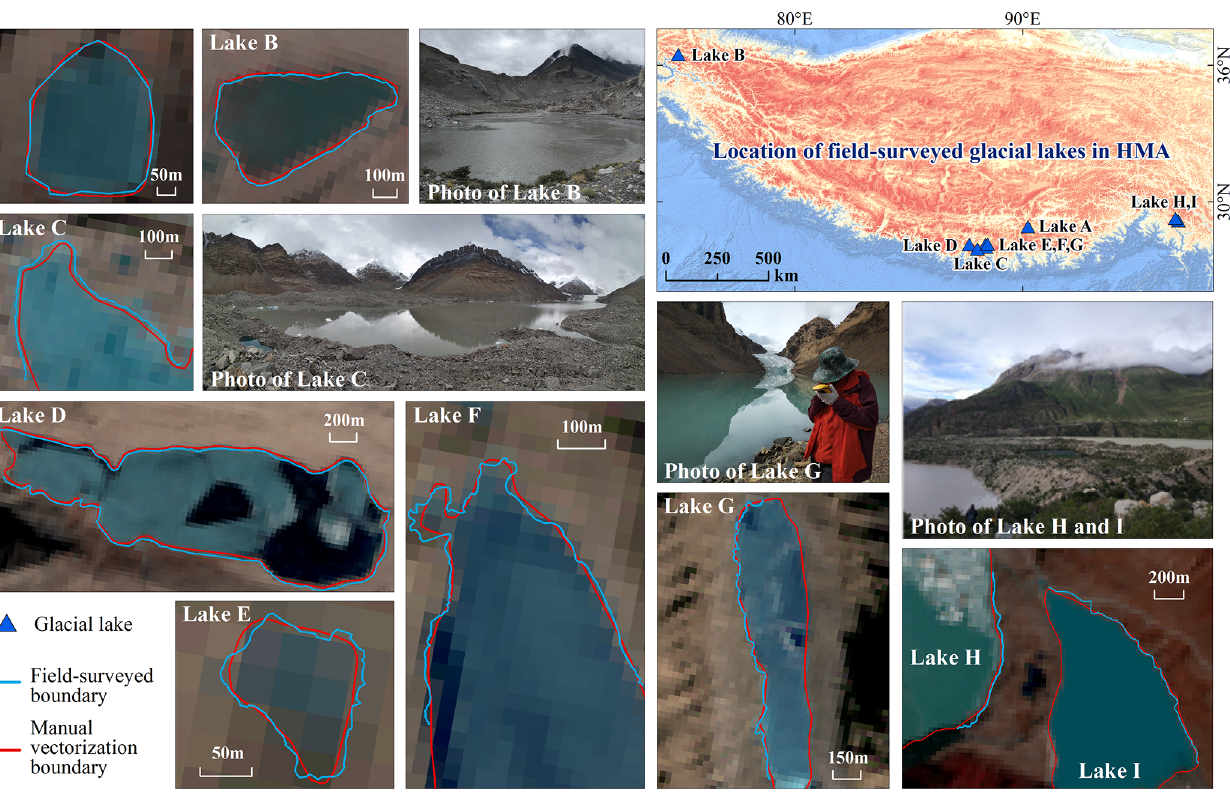
Figure 6. Glacial lakes in the HMA region surveyed in summer 2018 (the backgrounds of the surveyed lakes are Landsat OLI